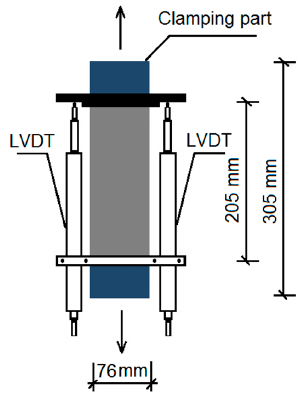
Figure 3. Diagrammatic drawing of the testing device.